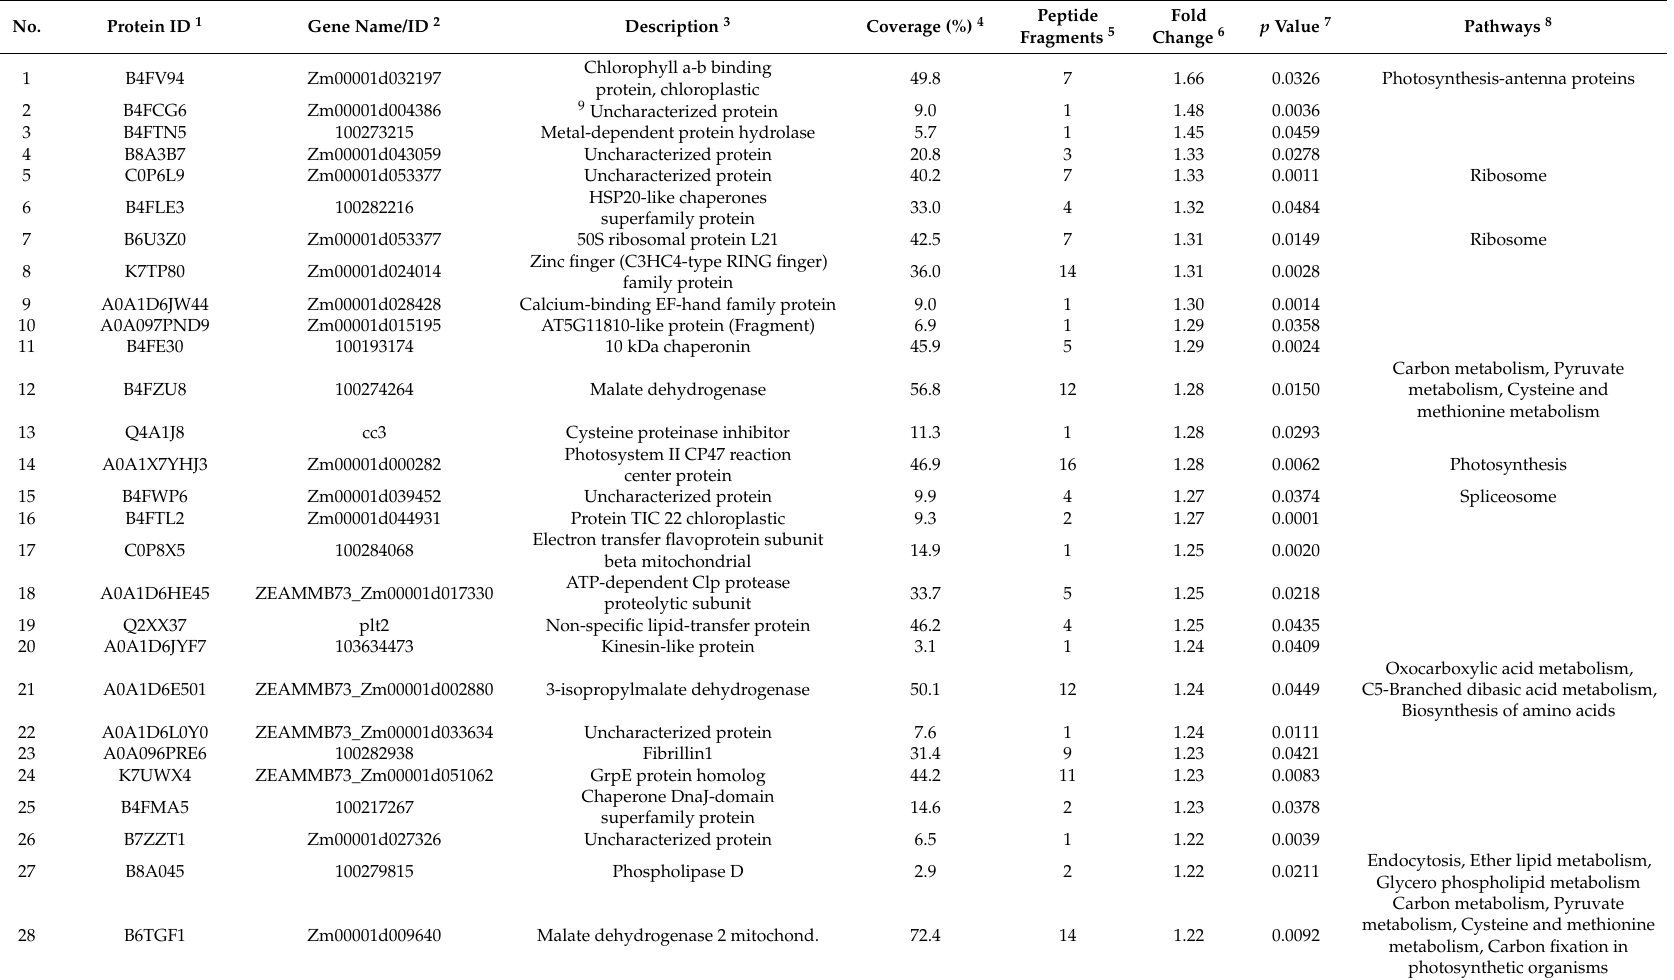
Table 3. Drought-responsive maize seedling leaf proteins observed specifically in sensitive line